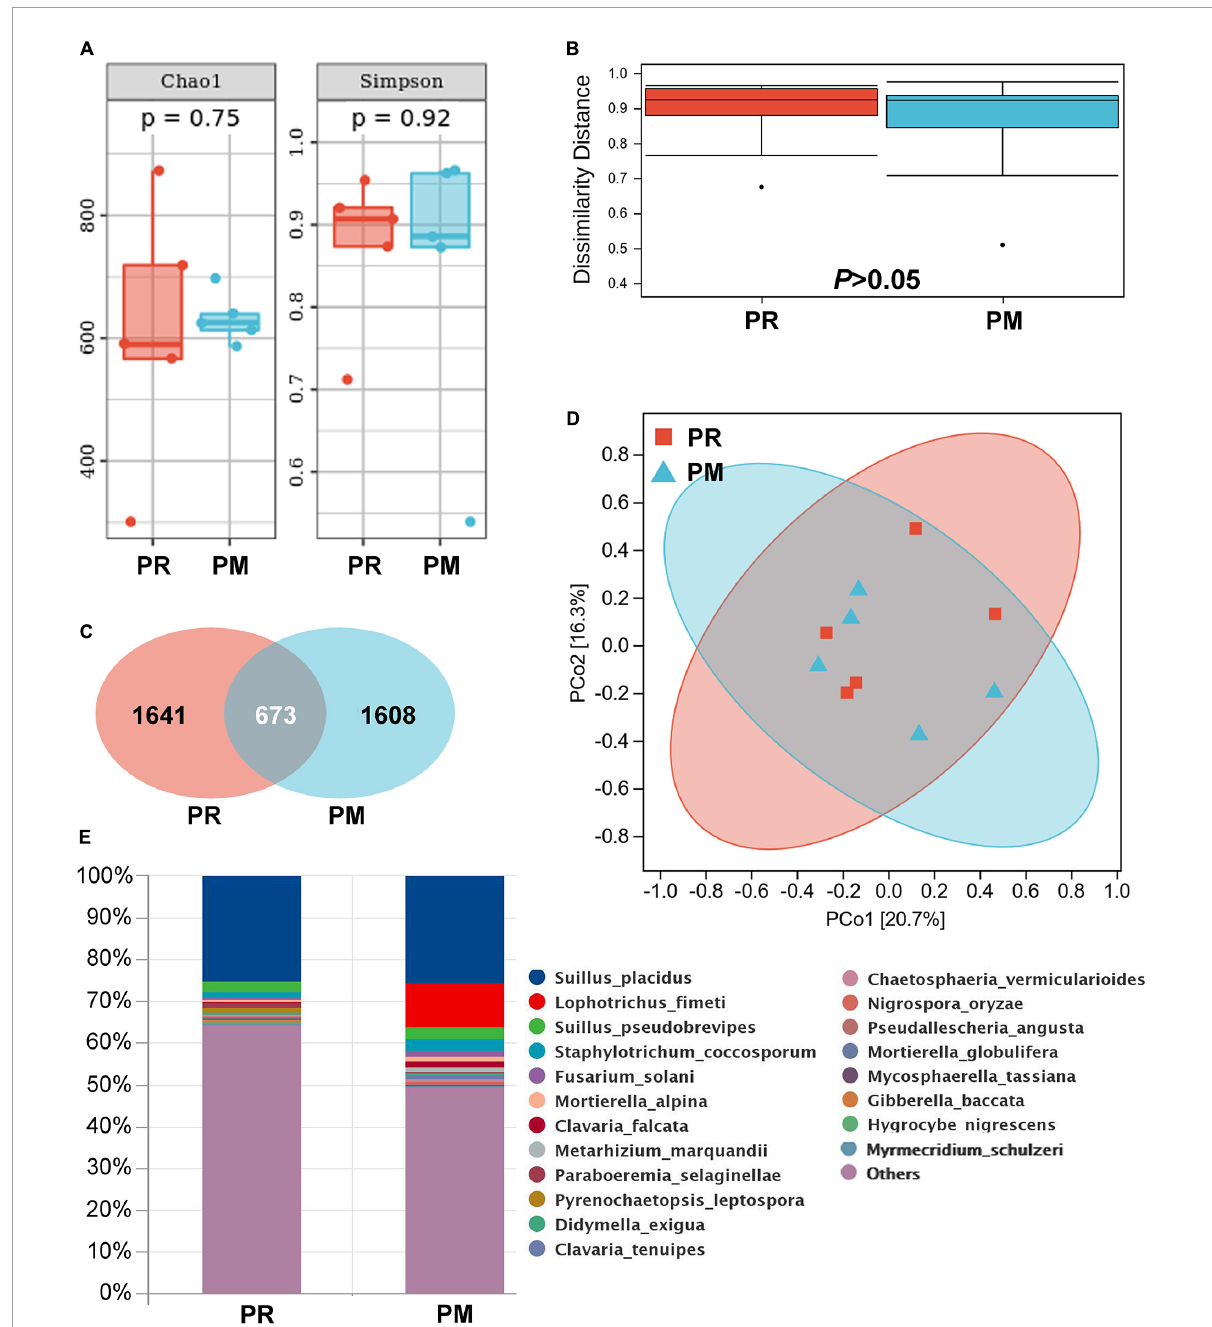
FIGURE3 Rhizosphere fungal community of Pinus radiata (PR) and Pinus massoniana (PM) trees in the Xifeng plantation. (A) Chao1 and Simpson indexes. (B) Dissimilarity distance. (C) Venn figure showing shared and unique operational taxonomic units (OTUs) between samples of two trees. (D) Principal Coordinate analysis (PCoA). (E) Relative abundance of fungal composition at the species